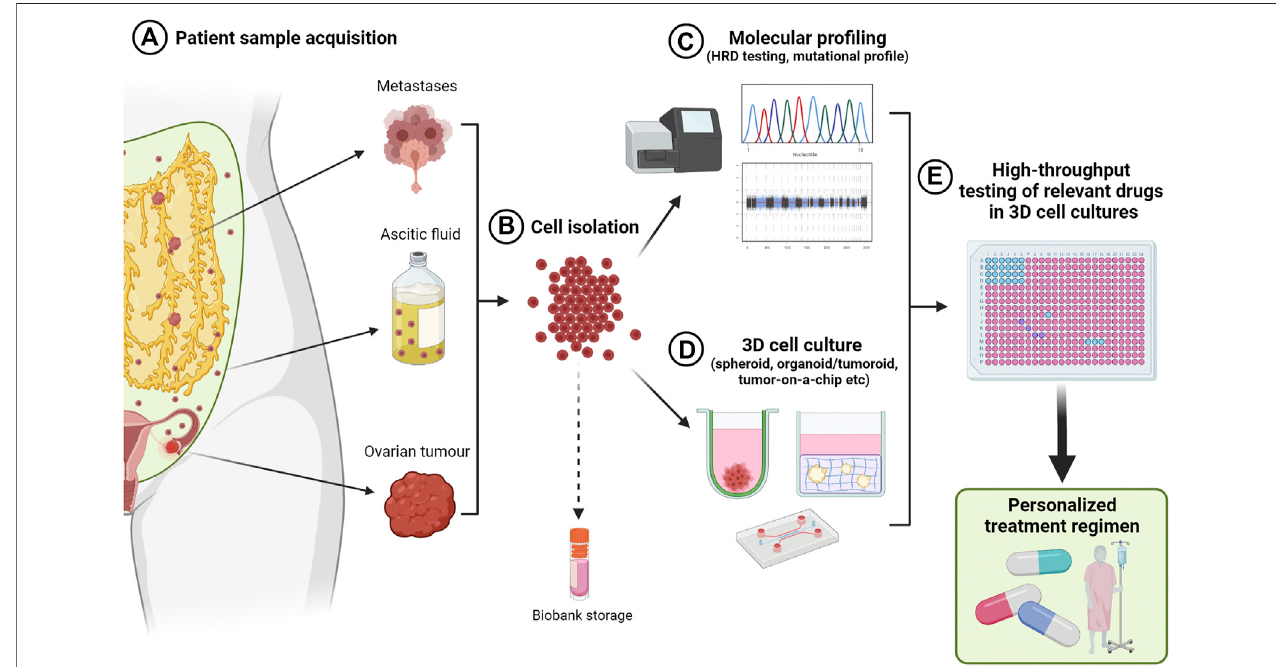
FIGURE 4 | A bench-to-bedside approach using 3D cell cultures to fast track personalized therapies for ovarian cancers. Utilization of (A) samples from multiple patient tumor sites, (B) isolation of cancer cells ex vivo for (C) molecular pro fi ling and (D) propagation as 3D cell cultures can identify clues regarding a patient ’ s unique tumor phenotype. Based on these fi ndings, (E) a high-throughput drug screen of molecularly relevant drugs in 3D cell cultures can be employed to predict drug ef fi cacy and utilized to guide a personalized medicine approach. Created with Biorender.com.